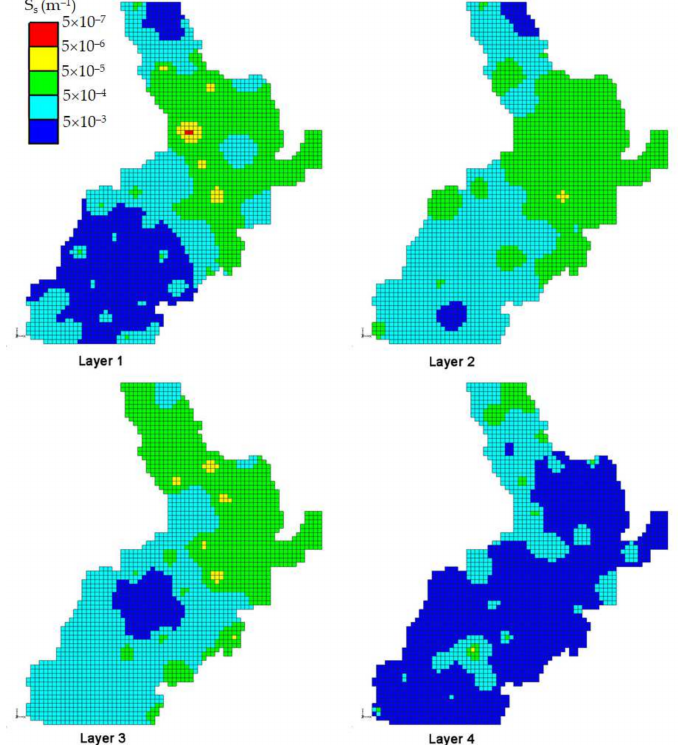
Figure 13. Spatial distribution of specific storage after model